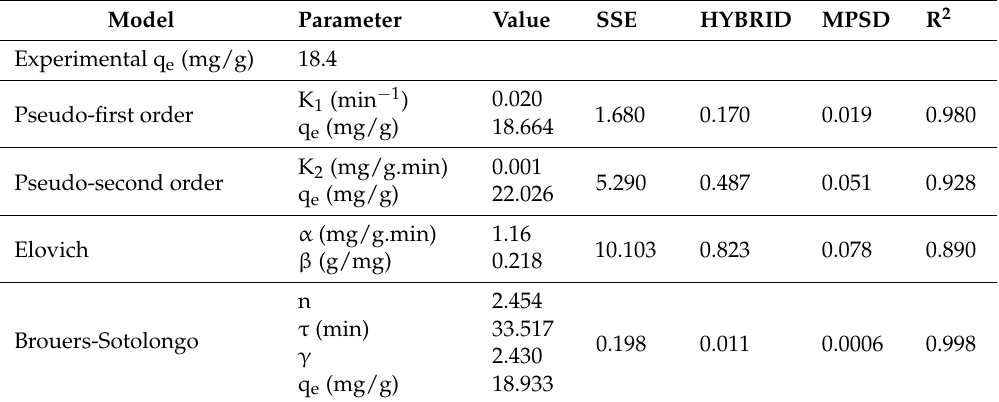
Table 5. Parameters of the kinetic models for the adsorption of copper by olive mill solid waste. Model